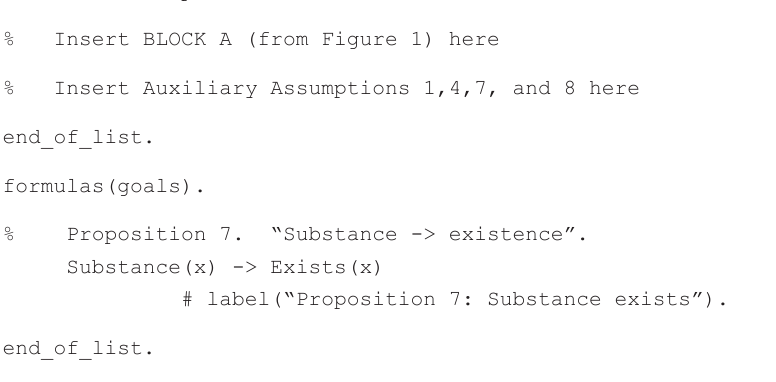
Figure 7: A prover9 script45 for generating a derivation of (SE) from the DAPI conjoined with Auxiliary Assumptions 1, 4, 7, and